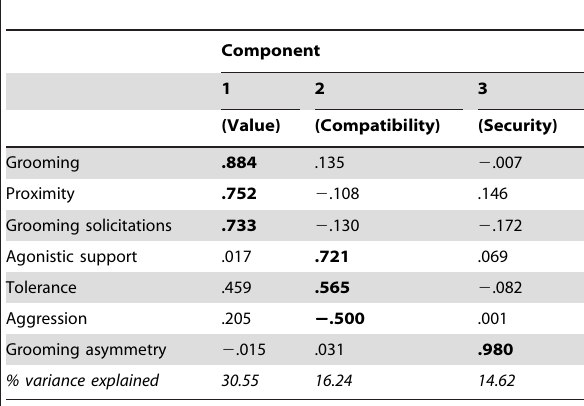
Table 2. Varimax rotated component matrix of the principal component analysis run on the seven variables measuring relationship quality (using scores per dyad).